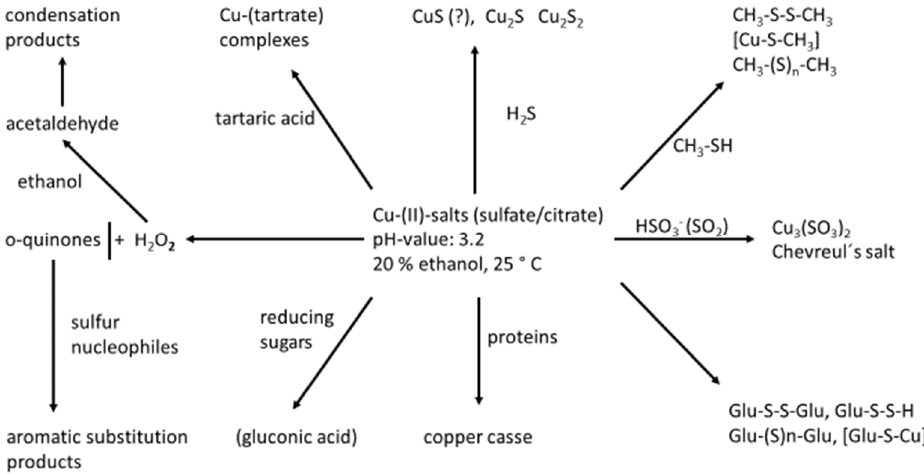
Figure 3. Reactions of wine components with copper ([56], modified).